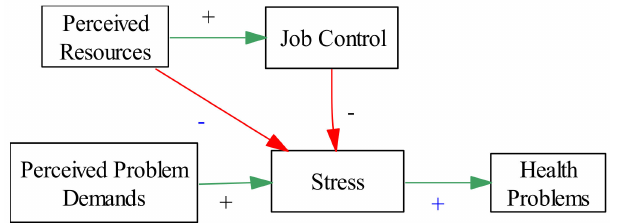
Figure 4. Morris et al. (2010) model [36] presented in a casual loop diagram. Note: green arrows indicate positive causal relations, and red arrows indicate negative causal